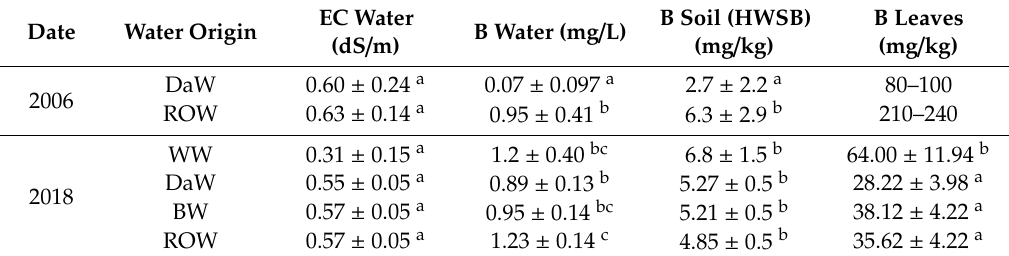
Table 1. Electrical conductivity (EC) (dS / m) and boron (B) in water (mg / L), soils (mg / kg), and banana leaves (mg / kg) of four water origins considering two periods: 2006 and 2018, with Dam Water: DaW (conventional resource), reverse osmosis water (ROW) (produced by reverse osmosis (RO) plants), well water (WW), and blend water (BW) (mixing di ff erent water qualities before being sold to farmers).